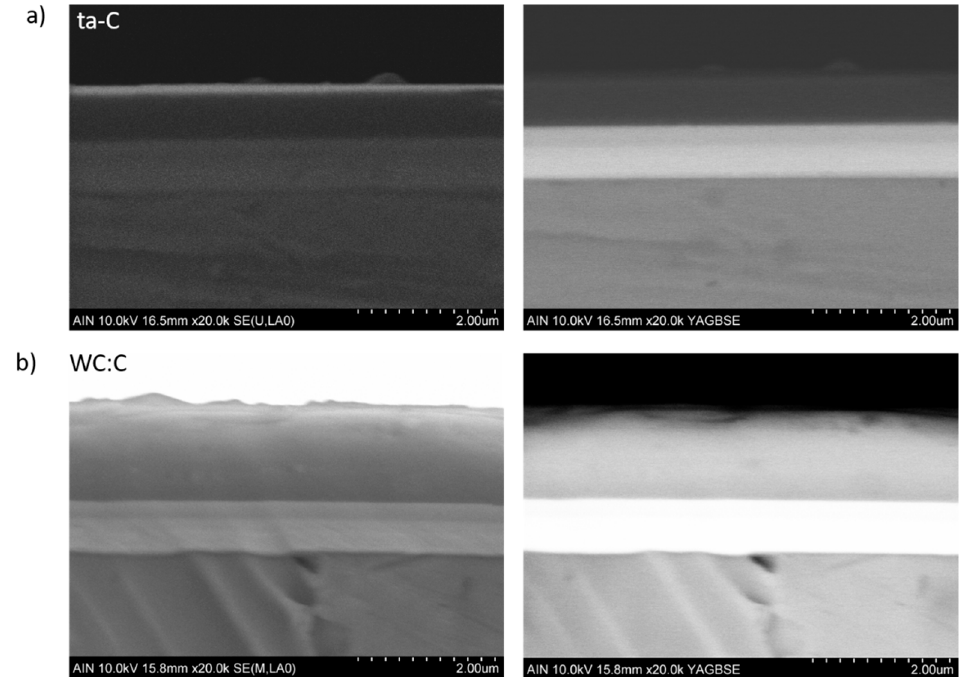
Figure 4. Cross-section SEM images for the sample of ta-C coating ( a ) and WC:C coating ( b ). On the left, the secondary electron signal (SE) images give some topographic information; on the right, the backscattered electron signal (BSE) images provide chemical contrast from the elements of the coatings.